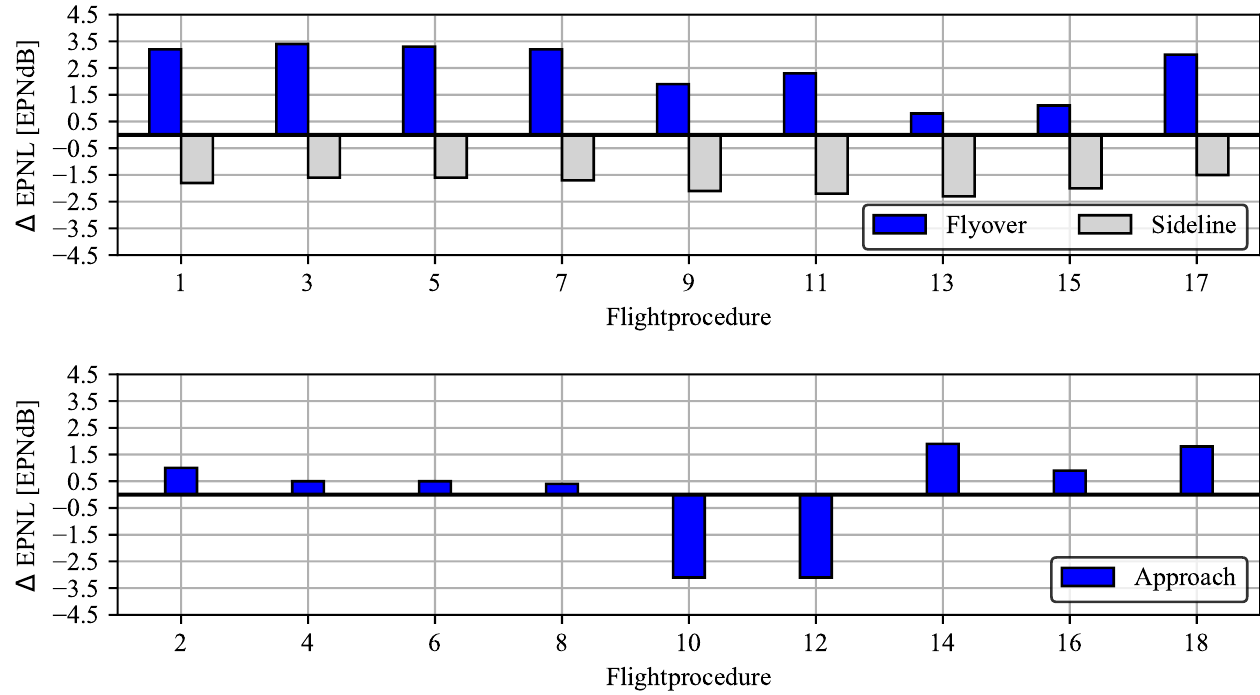
Figure 5. EPNL differences in simulated flight trajectories compared to published certification levels by the